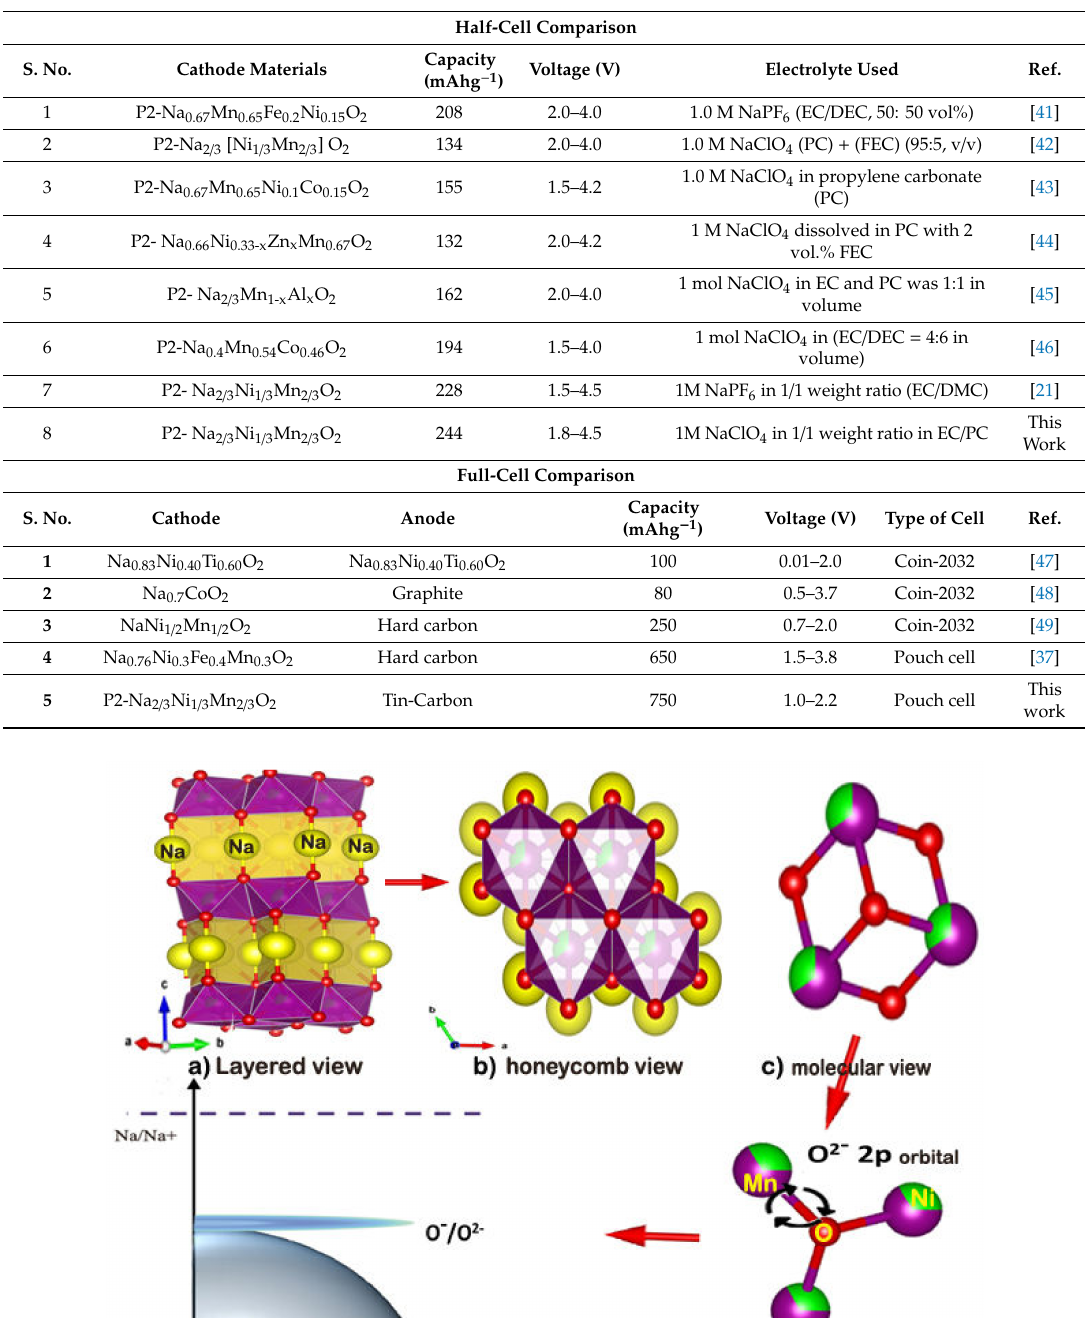
Table 1. Comparison of capacities of P2-Na electrodes reported in the literature for half-cell and full-cell couple.